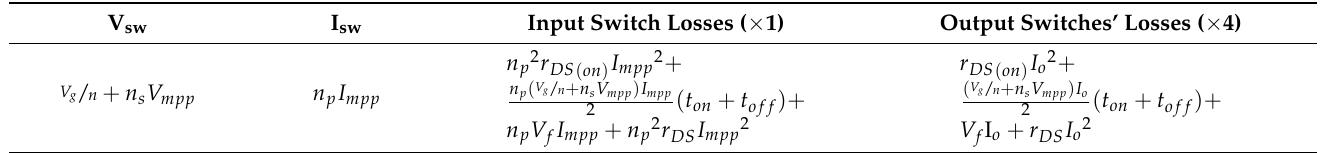
Table 7. Stresses and power losses of the Cuk modular